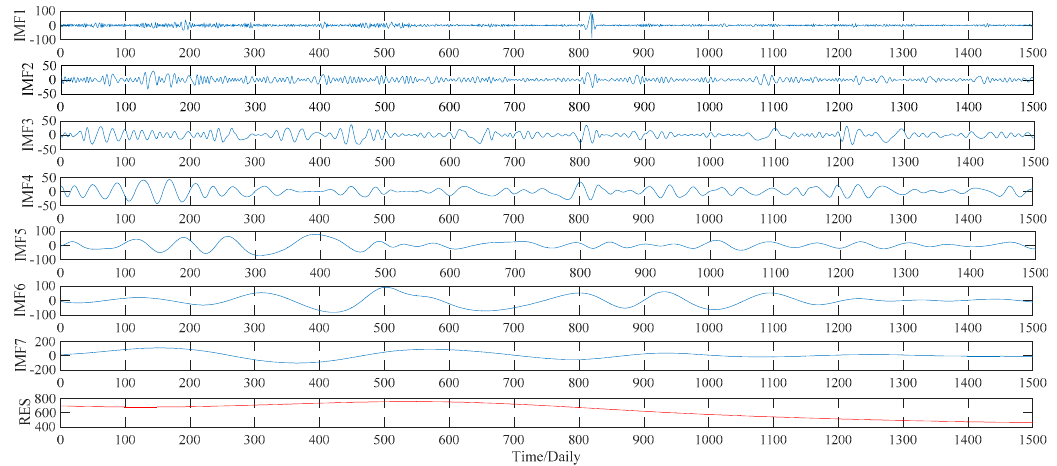
Figure 6. Training and forecasting results of the PSO–BPNN model (Wheat).